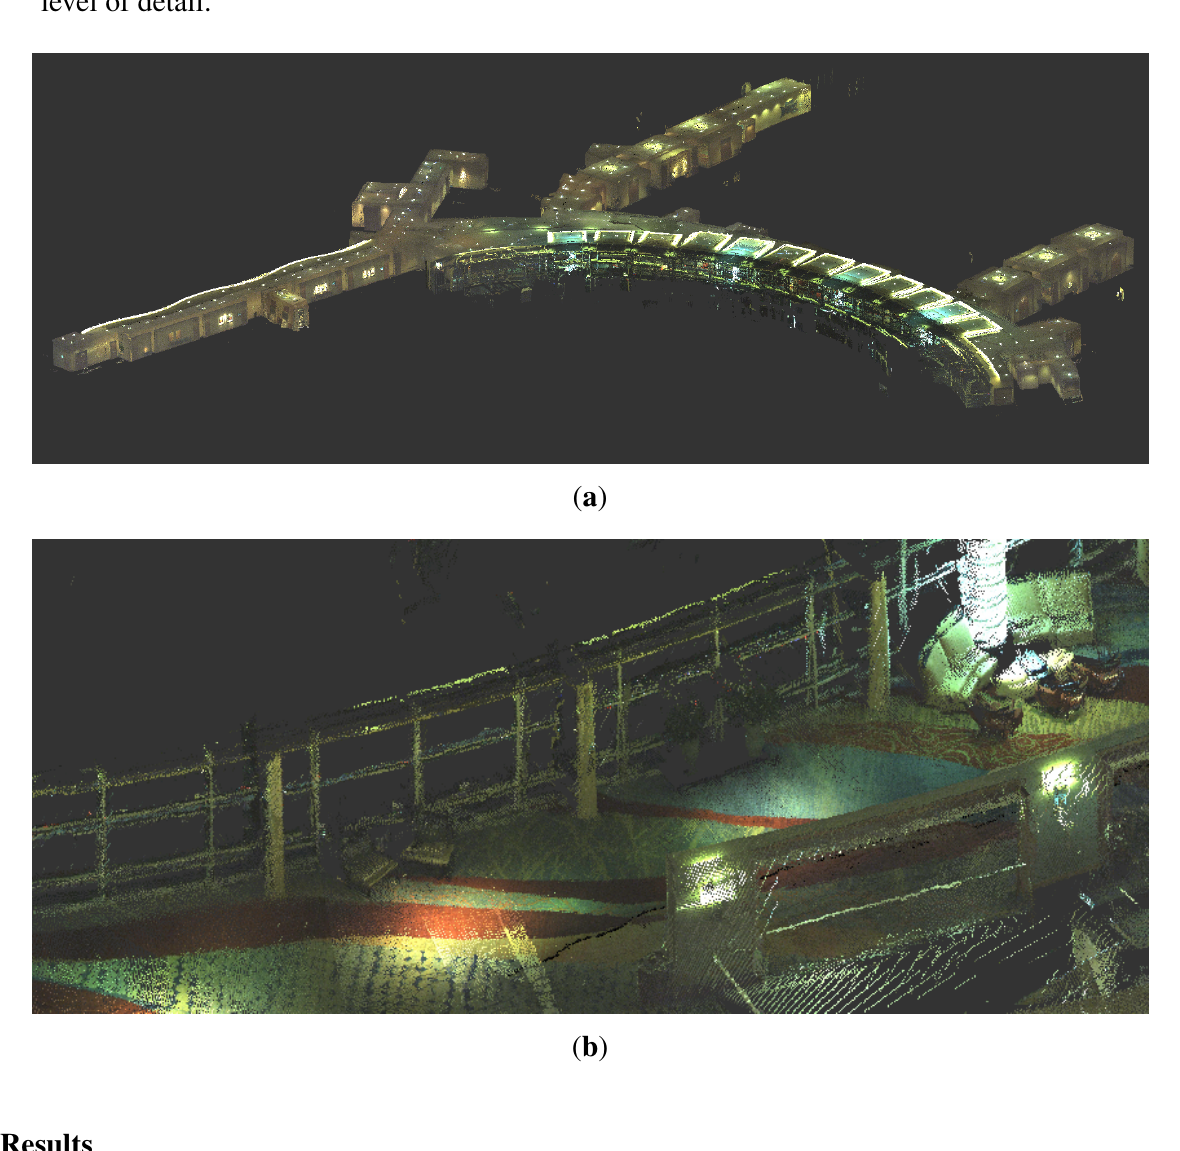
backpack system. ( b ) A close up view of an interior section illustrates the point clouds high level of